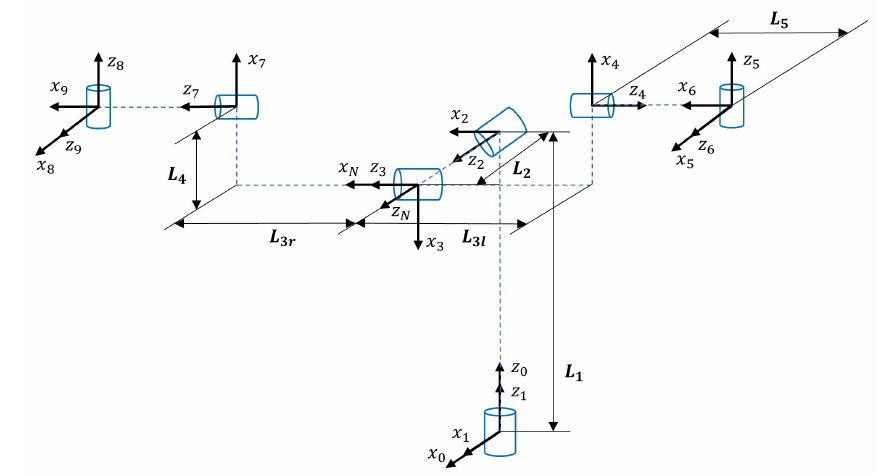
Figure 3. The definition of the robot bionic eyes’ coordinate